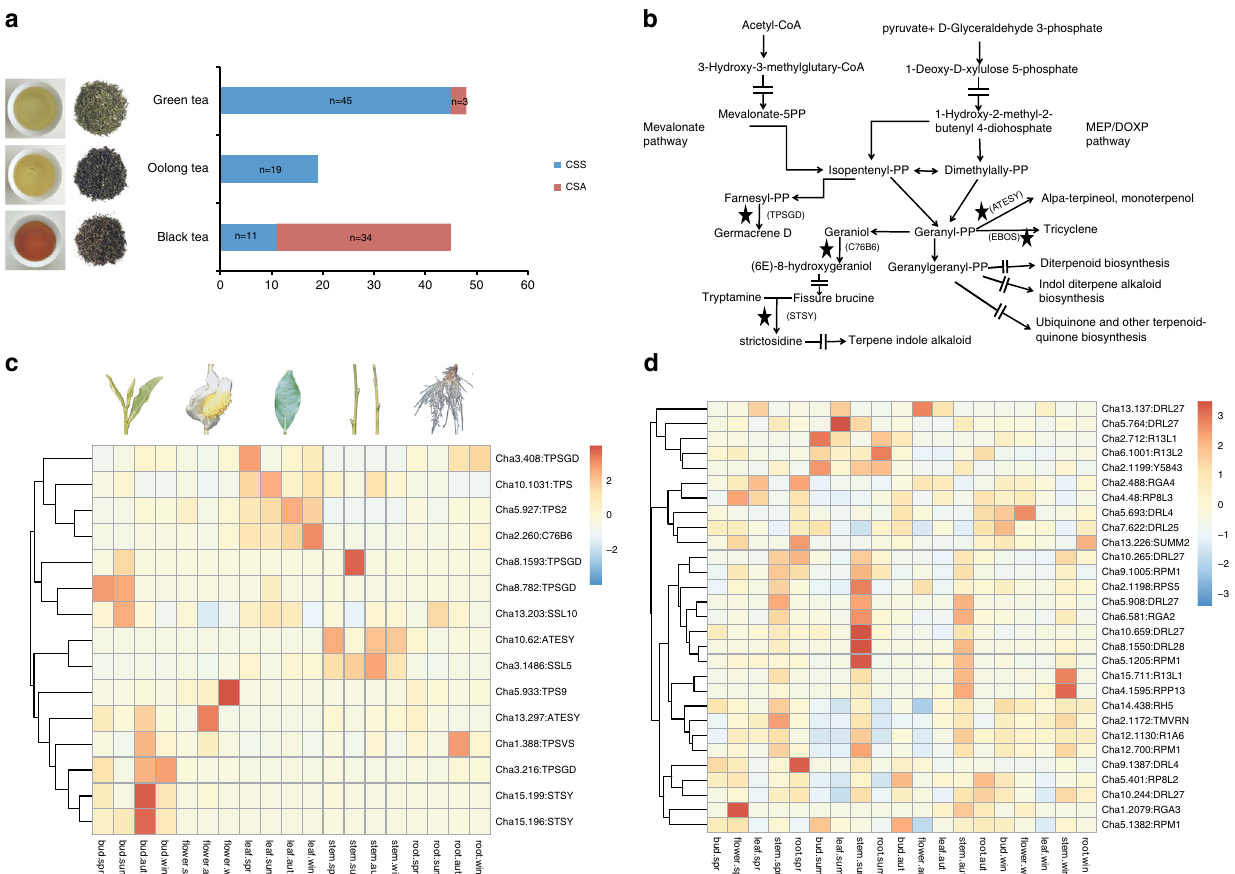
Fig. 3 Sweep genesets in CSA and CSS show different directions of domestication. a The tea types were used for SweepFinder2 analysis of CSS ( C. sinensis var. sinensis ) and CSA ( Camellia sinensis var. assamica ). b The pathway of terpene metabolism. The selective sweep genes are indicated by stars. The arrows bisected by equal symbols indicate hidden processes. c The expression of terpene-related genes in different tea tissues. d The expression of NBS-ARC genes in different tea tissues. Source data underlying Fig. 3c, d are provided as a Source Data fi